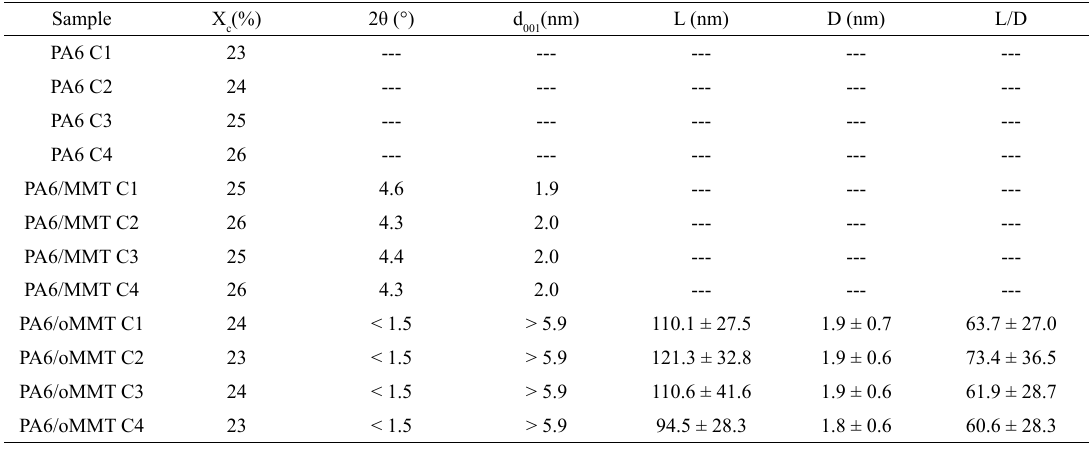
Table 3. Parameters obtained from DSC (X TEM (L = length, D = thickness and L/D = average aspect ratio of the oMMT particles in the PA6 matrix) measurements for the blown film samples.